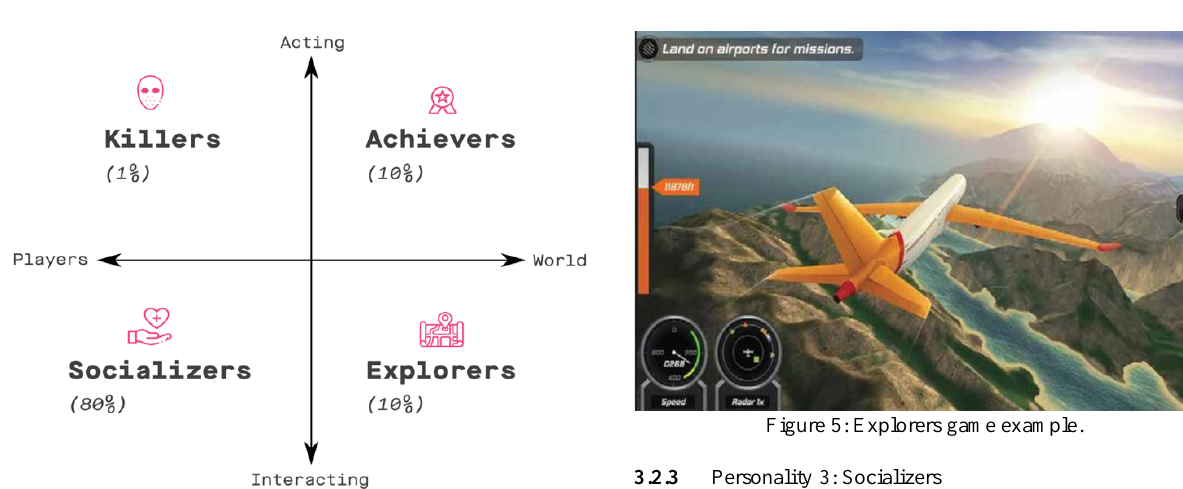
Figure 3: Types of personalities.